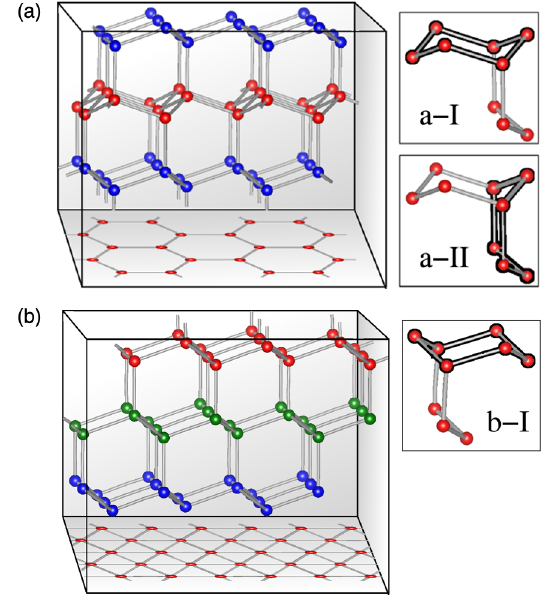
FIG. 1. The oxygen sublattices in (a) hexagonal ice Ih and (b) cubic ice Ic consist of ABAB and ABC stacked puckered layers (red, blue, and green colors), respectively. Projections of the periodic structures along the direction orthogonal to the puckered layers are shown on the lower faces of the diagrams. Ih is built of the chair- and boat-form hexamers shown in a-I and a-II, respectively, while Ic is built exclusively from chair-form hexamers as in b-I. The structures were visualised using VESTA